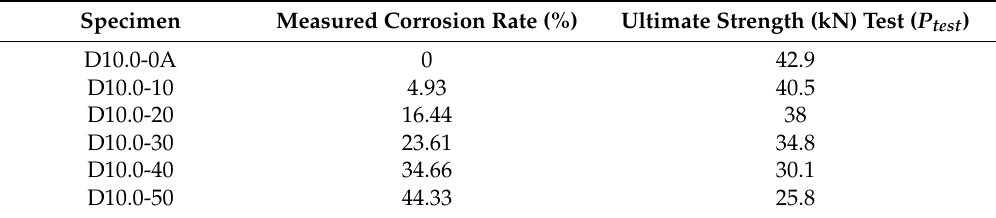
Table 7. Ultimate strengths for the D10.0 series push out test specimens.